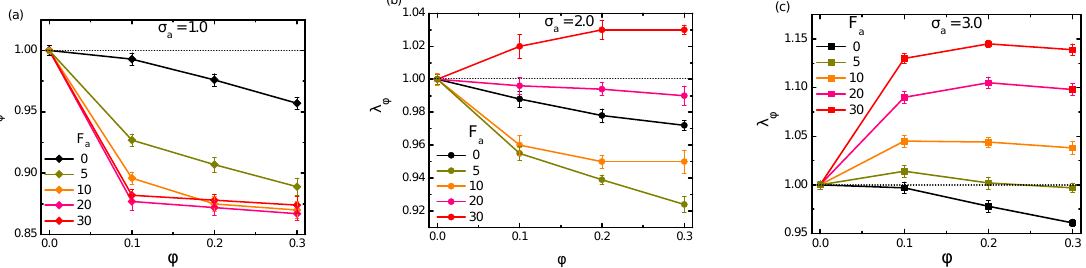
Figure 9. Dependence of scaled gyration radius λ φ on volume fraction φ in an active bath, under varying active forces, with three different crowder sizes: σ a = 1.0 ( a ); σ a = 2.0 ( b ), and σ a = 3.0 ( c ). The polymer’s rigidity is given as κ = 1.0. Error bars correspond to one standard